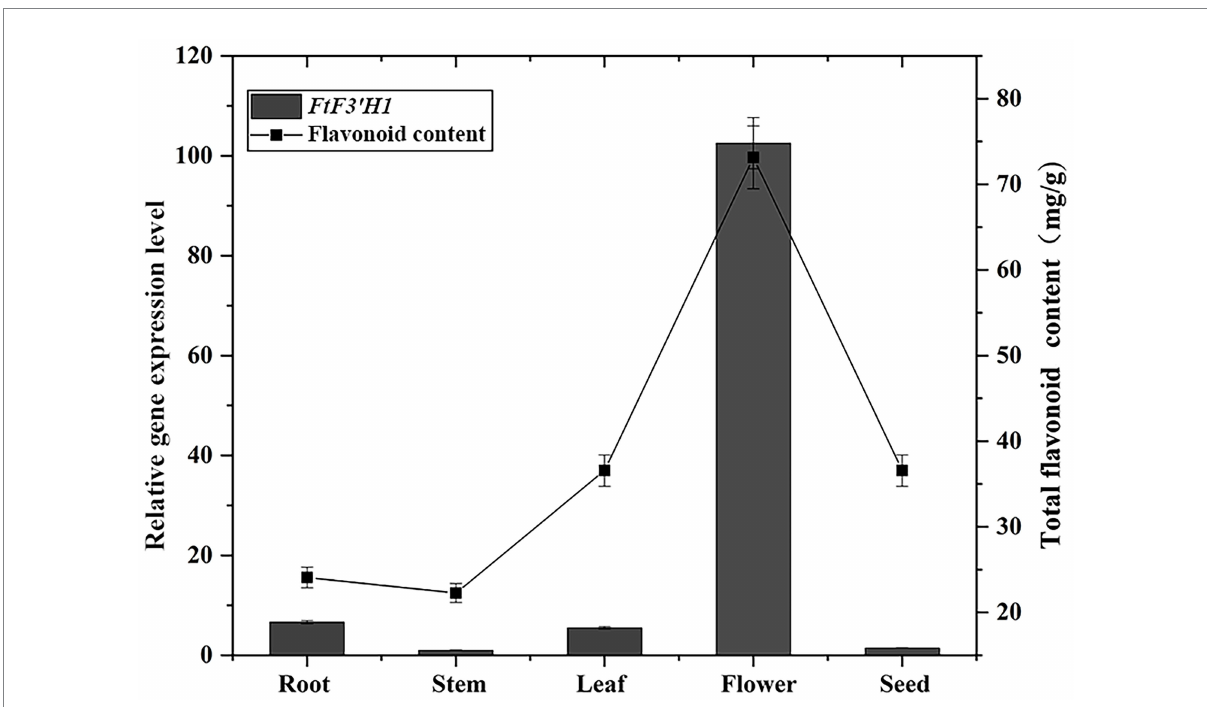
FIGURE 3 Relationship between flavonoid content and FtF3 ′ H1 transcript level in different tissues of TB at flowering stage. The expression of FtF3 ′ H1 was determined by qPCR. FtH3 gene was used as the reference gene. Determination of total flavonoids of TB by UV spectrophotometer. The average value is calculated repeatedly by three times of technology. Error bars indicate standard deviations (±